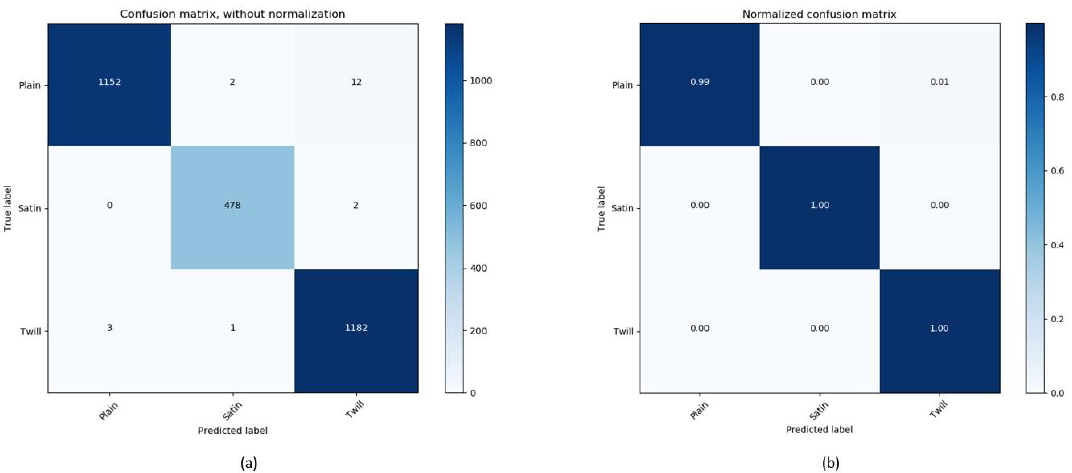
Figure 7. Confusion matrix for plain, satin, and twill weave fabrics. ( a ) Confusion matrix, without normalization; ( b ) Normalized confusion